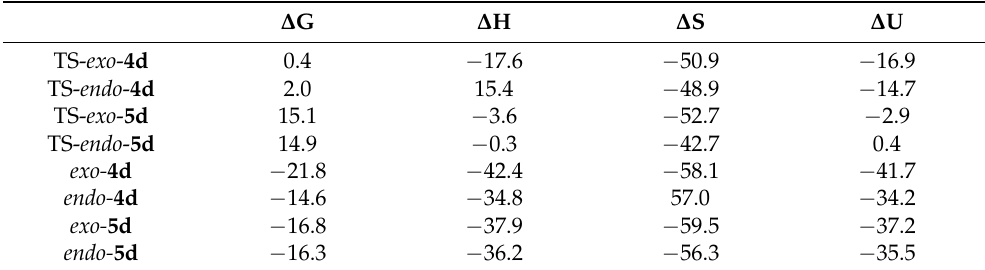
Table 3. Difference in the Gibbs free energies ( ∆ G, in kcal mol − 1 ), enthalpies ( ∆ H, in kcal mol − 1 ), entropies ( ∆ S, in cal K − 1 mol − 1 ), and electronic energies ( ∆ U, in kcal mol − 1 ) for TSs and products calculated at the ω B97xd/6-31G(d,p) level of theory. ∆